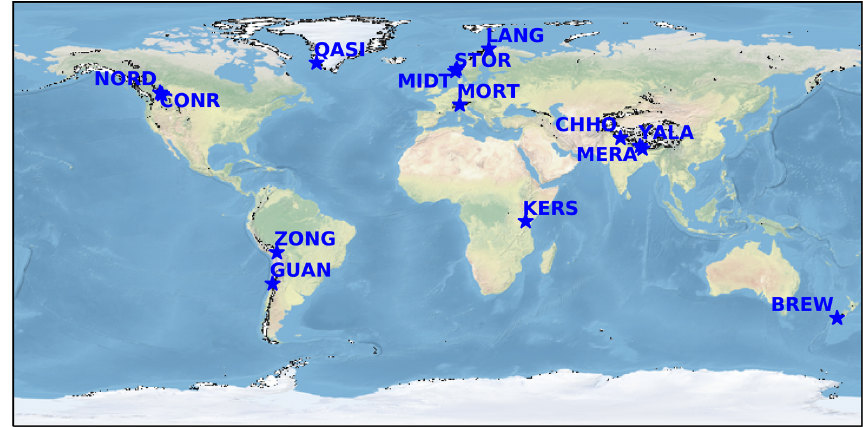
Figure 1. Map showing the location of study sites with short names (see Table 1 for full names) along with glacier areas from the Randolph Glacier Inventory (black outlines; RGI Consortium, 2017). Note that the two Conrad Glacier sites (CABL, CACC) are shown as CONR and the two Mera Glacier sites (MERA, NAUL) are shown as MERA. The background map is Natural Earth shaded relief.